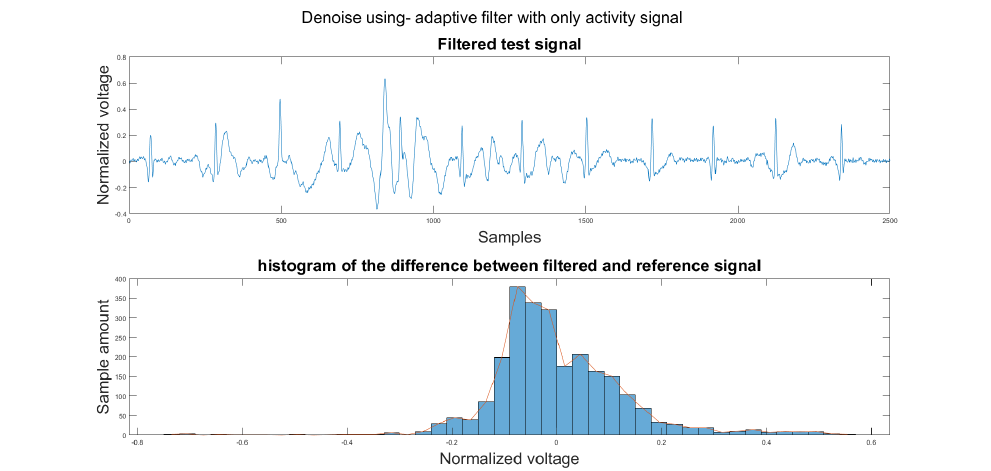
Figure A13. (1) Test signal, (2) histogram of the difference.